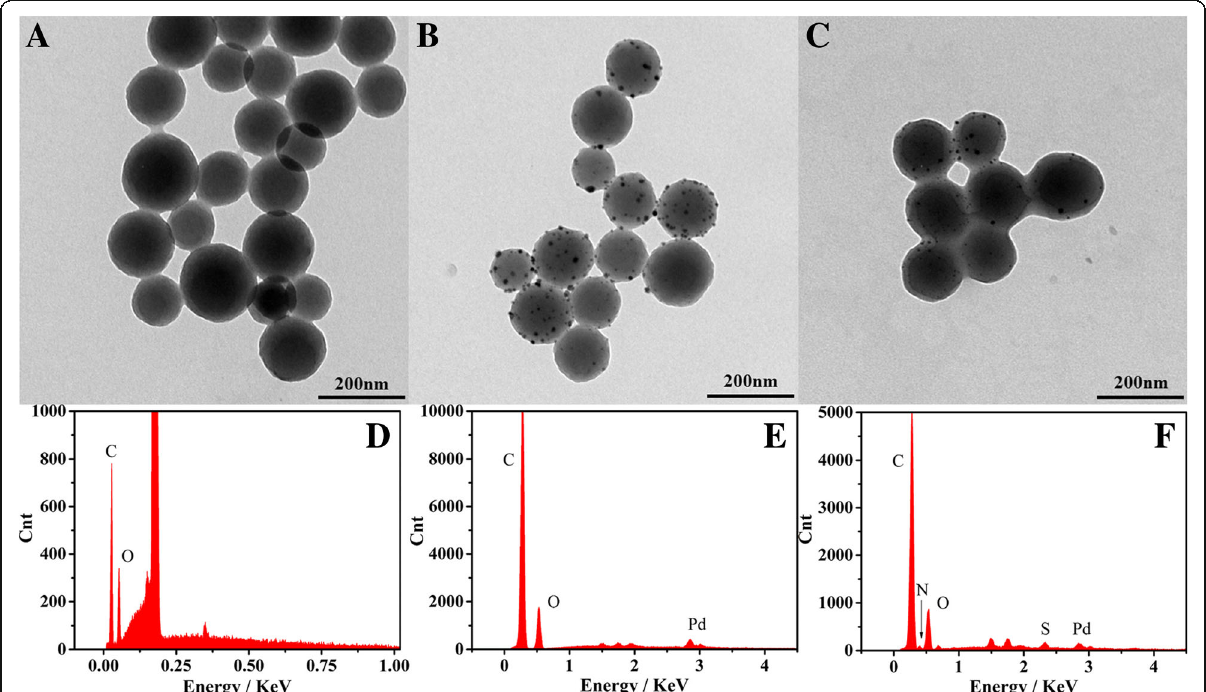
Fig. 2 TEM micrographs of carbon nanosphere ( a ), Pd-carbon nanospheres ( b ) and Pd-CNCs ( c ) EDS of carbon nanosphere ( d ), Pd-carbon nanospheres ( e ) and Pd-CNCs ( f )